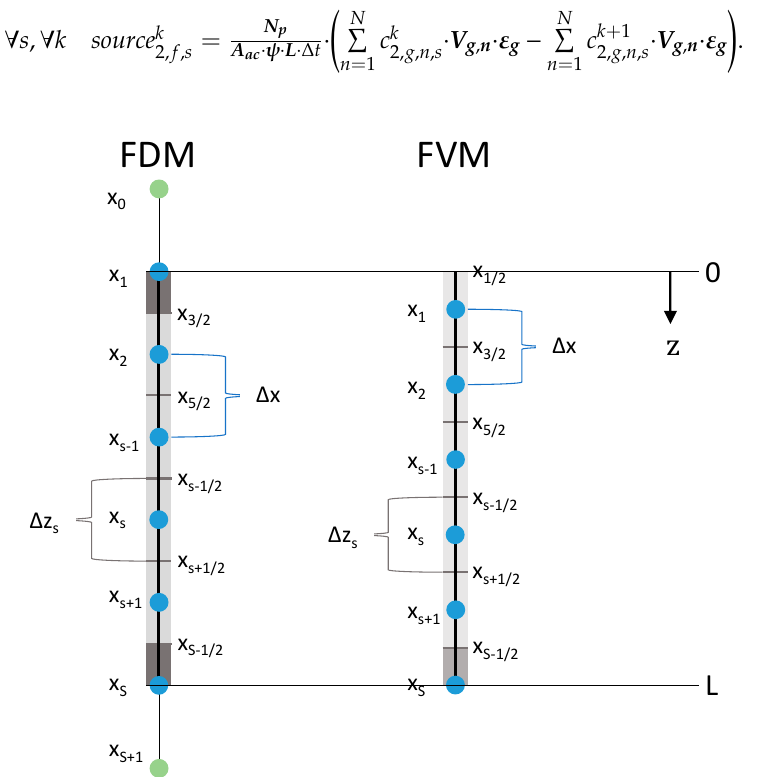
Figure 2. Axial discretizations of the packed bed for FDM and FVM. S —number of nodes, x s —s th node (blue), x 0 , x S + 1 —artificial node (green), ∆ x —distance between neighboring nodes, x (in the middle of two neighboring nodes), ∆ z s —length of volume element (grey boxes, boundary boxes in dark grey).